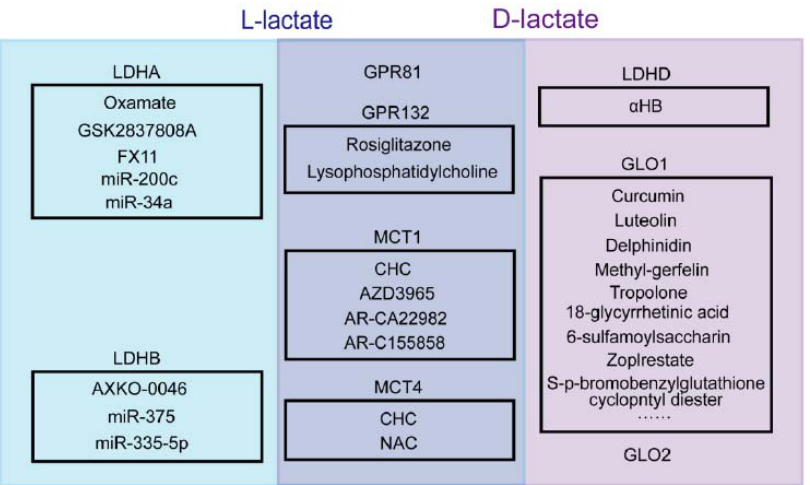
Figure 2. A graphic describes the lactate metabolism related molecular hallmarks and their